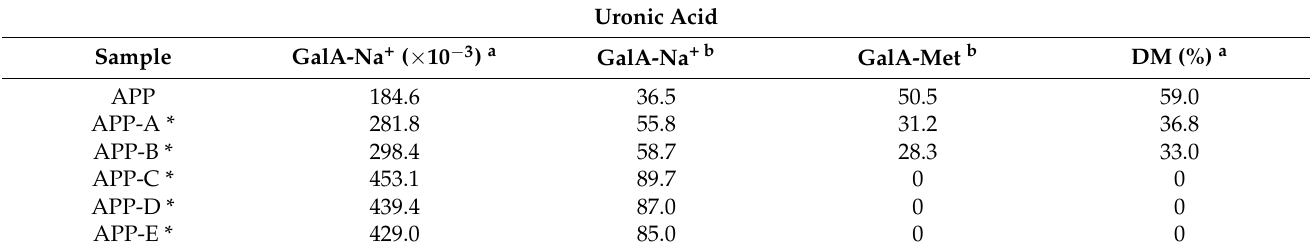
Table 1. Galacturonic acid and DM of pectins obtained from the Araç á pulp.